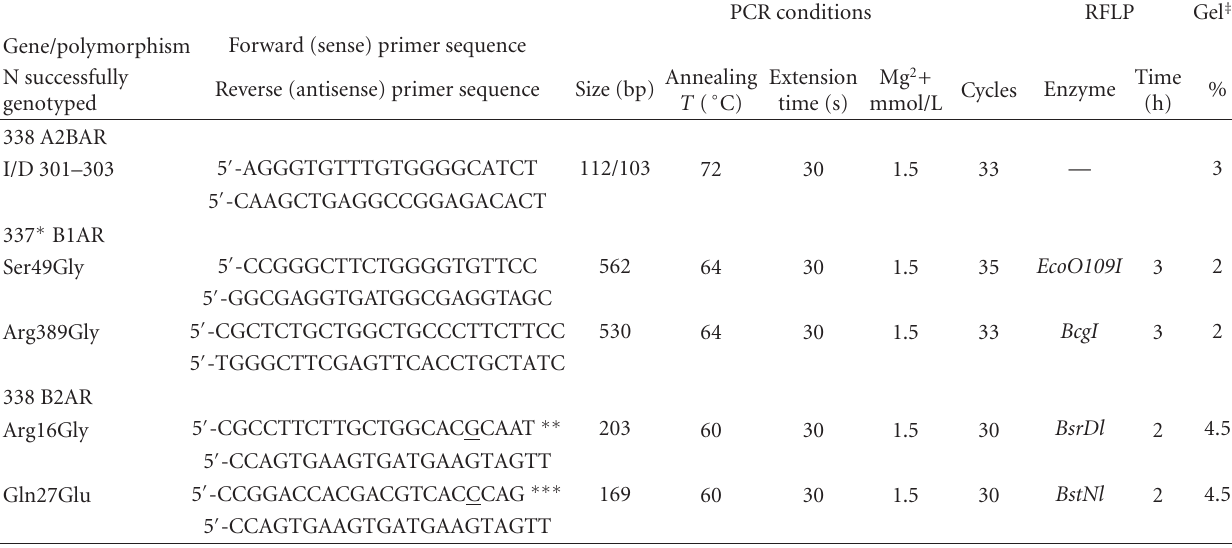
Table 1: PCR and digestion conditions for genotyping of the the α 2 B -, β 1 -, and the β 2 -adrenergic receptor gene polymorphisms.